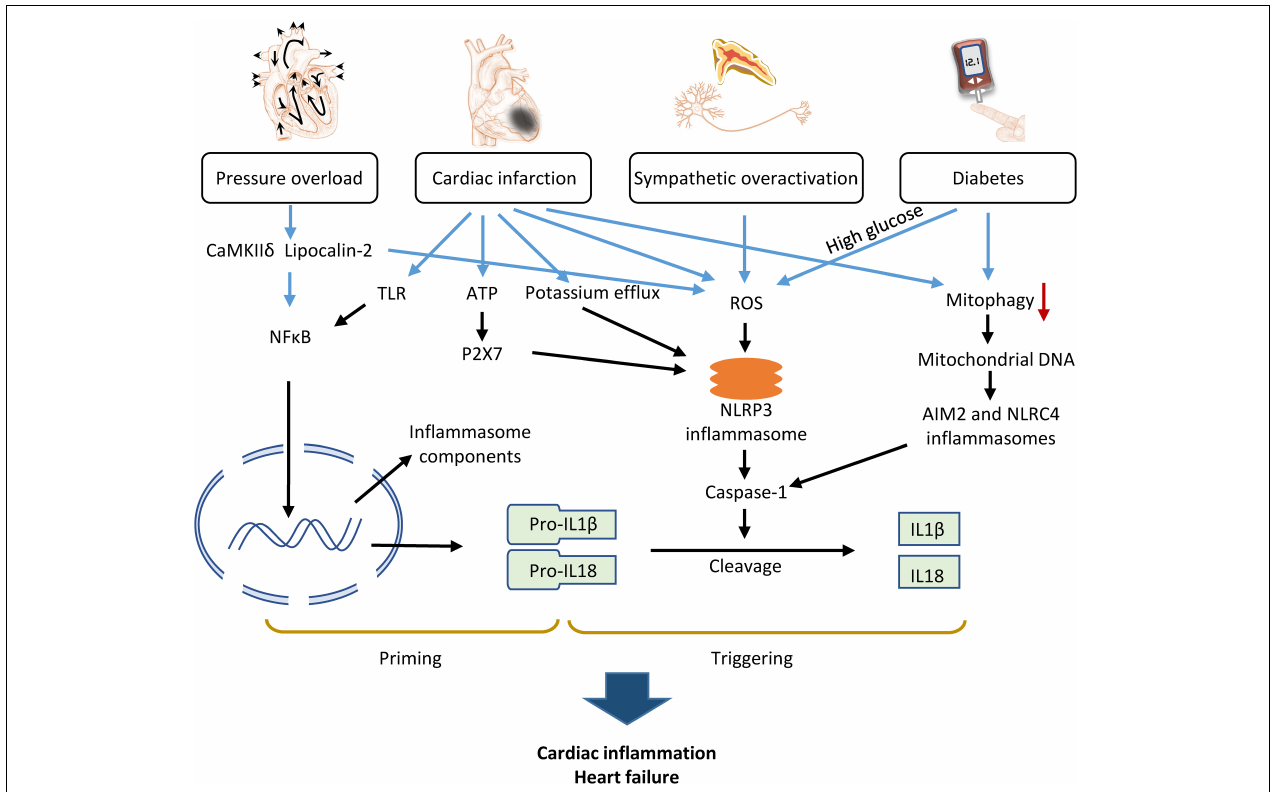
FIGURE 2 | Mechanism of inflammasome activation by pathologic factors contributing to heart failure. Pressure overload, cardiac infarction, diabetes, and sympathetic overactivation caused either priming or triggering of inflammasomes via various molecular signaling pathways, which converge to activate caspase-1 and consequently, IL-1 β and IL-18, promoting cardiac inflammation and